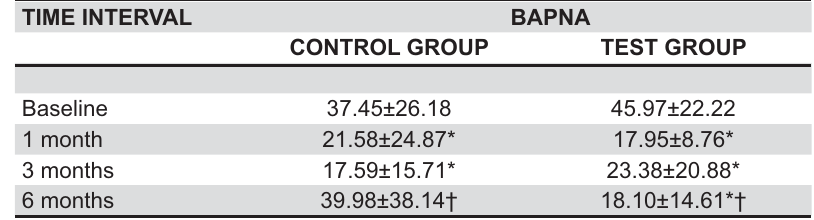
Table 4- (cid:3)(cid:26)\(cid:6)(cid:9)(cid:12)^(cid:14)"(cid:10)\_\(cid:7)(cid:20)(cid:15)(cid:11)(cid:12)(cid:11)(cid:12)(cid:9)\(cid:23)\(cid:12)(cid:11)(cid:5)(cid:20)(cid:14)(cid:7)(cid:12)(cid:11)(cid:10)(cid:11)(cid:18)(cid:9)(cid:3)!(cid:30)(cid:4)(cid:28)(cid:26)(cid:4)<(cid:3)(cid:20)(cid:9)(cid:8)(cid:25)(cid:10)(cid:5)(cid:8)(cid:3)!(cid:12)(cid:22)(cid:14)(cid:10)(cid:3)(cid:23)(cid:20)(cid:14)(cid:18)(cid:25)(cid:17)(cid:5)‘(cid:22)(cid:15)(cid:3)(cid:18)(cid:9)(cid:12)(cid:5)(cid:7)(cid:10)(cid:3)(cid:6)(cid:11)(cid:14)(cid:16)(cid:10)(cid:22)‘(cid:22)(cid:11)(cid:12)(cid:25)(cid:5)(cid:9)<(cid:3)(cid:7)(cid:5)(cid:3)(cid:18)(cid:11)(cid:19)(cid:19)(cid:9)(cid:20)(cid:9)(cid:12)(cid:5)(cid:3)(cid:5)(cid:11)(cid:22)(cid:9)(cid:3) intervals for control and test